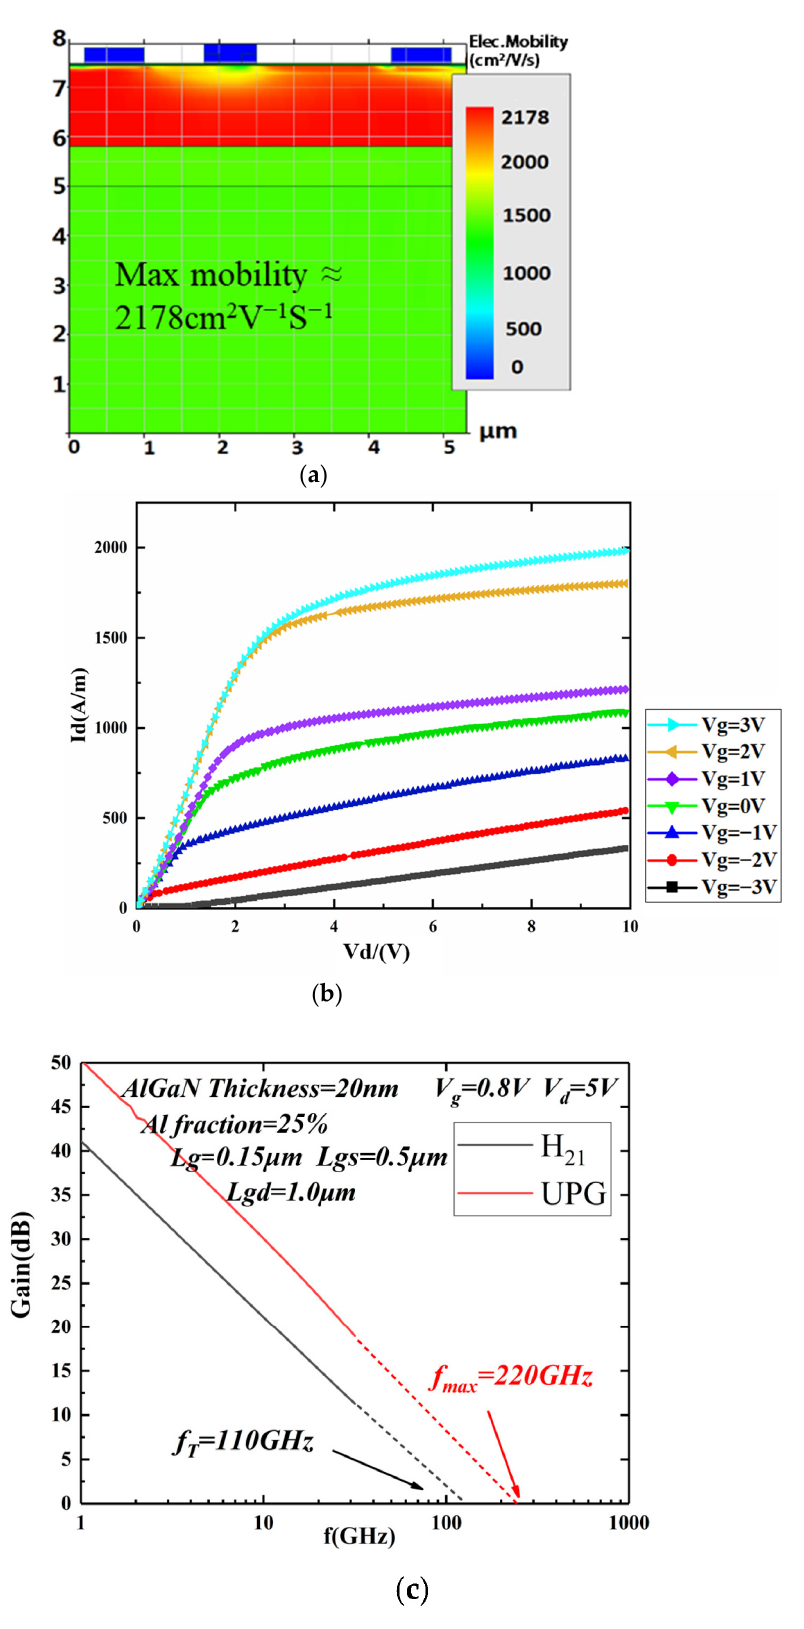
Figure 12. Device simulation results: ( a ) Mobility simulation and ( b ) output characteristics ( c ) f t and f max .